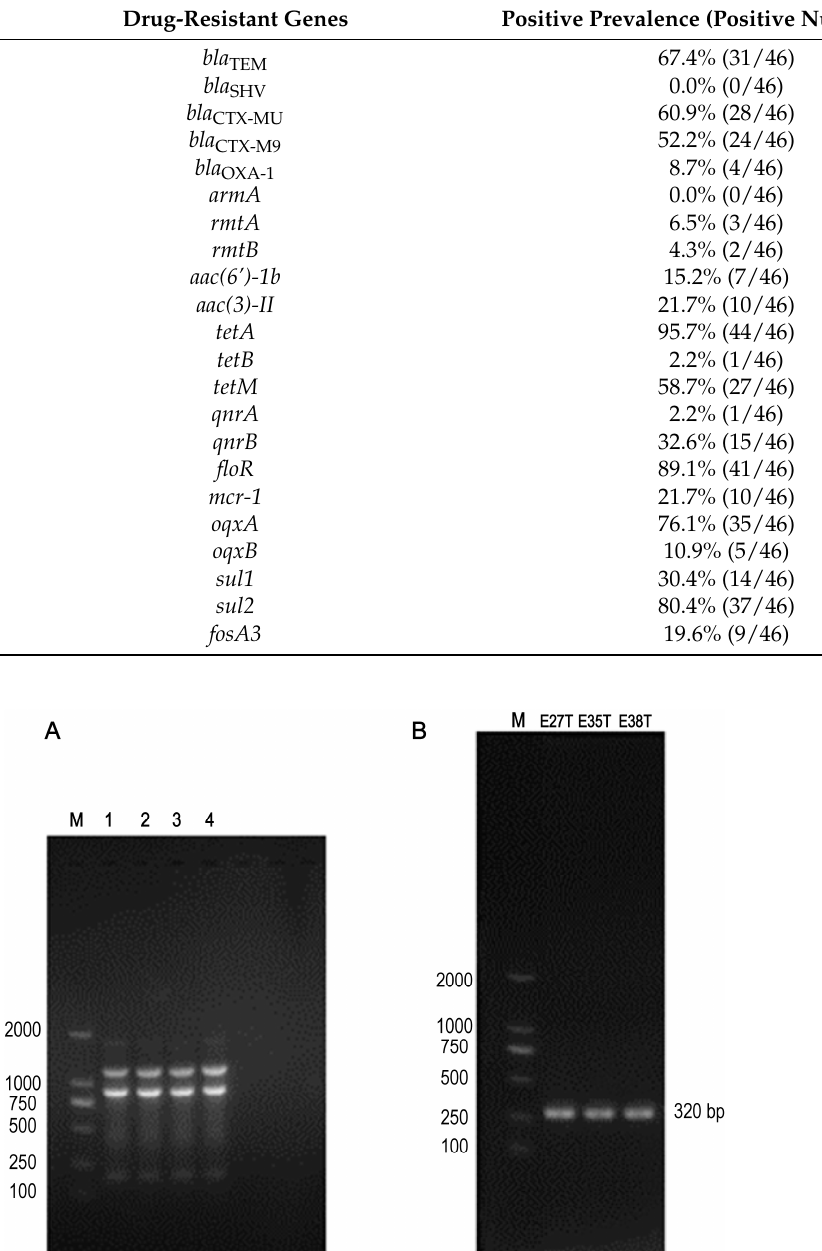
Table 5. Prevalence of antimicrobia-resistant genes in sul3 positive E. coli .